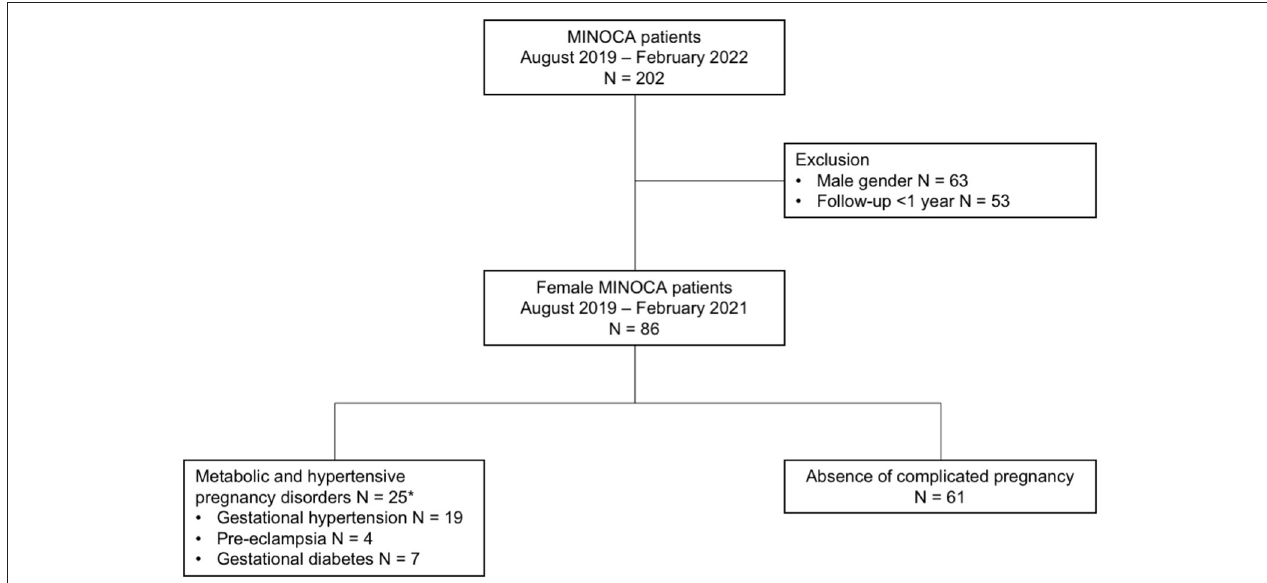
FIGURE 1 | Flow-chart of included MINOCA patients. * As some patients had multiple metabolic and hypertensive pregnancy disorders, numbers do not sum to 25.